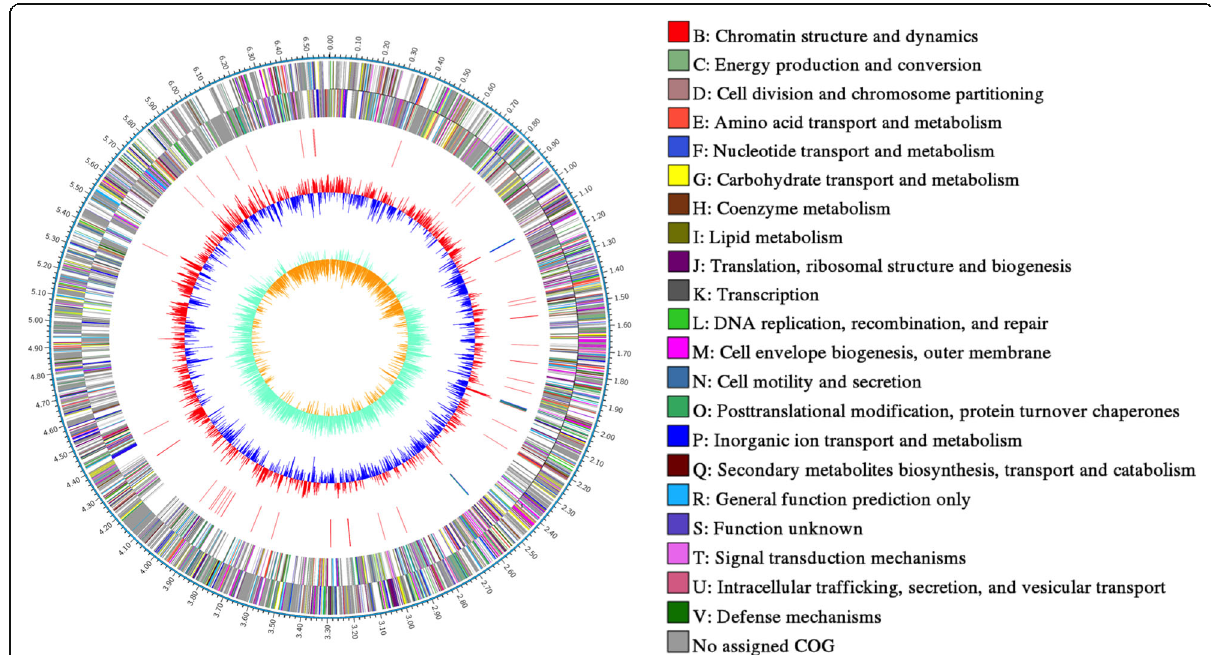
Fig. 4 Rooted phylogenetic tree of the 16 S rRNA sequences of Pedobacter steynii strain DX4 and relative species. The 16 S rRNA sequences of Pedobacter species were aligned, and the phylogenetic tree was constructed by using Neighbor-joining method based on the maximum composite likehood substitution model